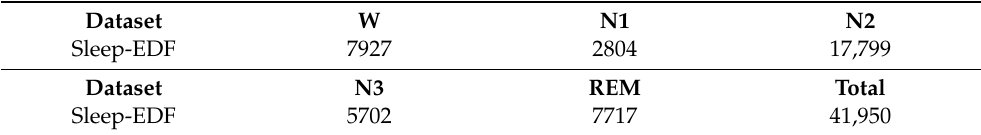
Table 2. The category and quantity of Sleep-EDF dataset.